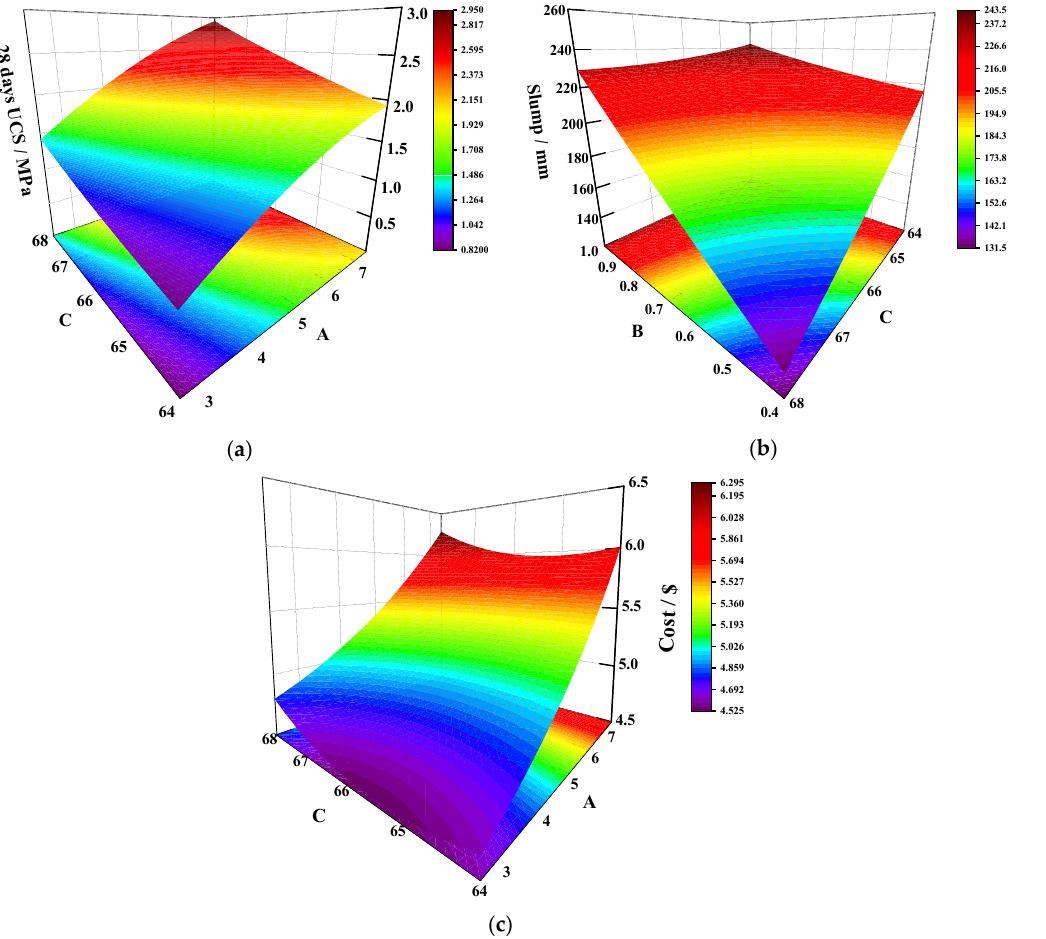
Figure 6. Interaction response surface plots of factors: ( a ) effect of factor AC on the 28 days UCS; ( b ) effect of factor BC on the slump; and ( c ) effect of factor AC on the cost.